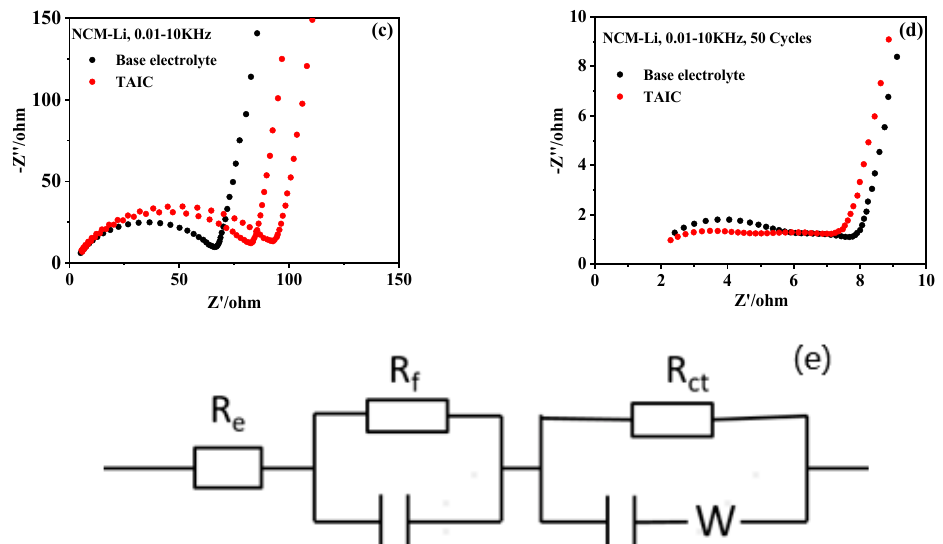
Figure 3. ( a ) The cycle curve of NCM-Li half-cell (The solid balls represent the cyclic capacity attenuation, and the hollow balls represent the charging-discharging efficiency in the cyclic process); ( b ) The charge–discharge curve during the charging process; ( c ) Representative EIS Nyquist plots of NCM-Li half-cells prepared with different electrolyte models measured after the first discharge–charge cycle at 0.1 C; ( d ) Representative EIS Nyquist plots of NCM-Li half-cell with different electrolyte models after the 50th discharge–charge cycle; ( e ) An equivalent circuit model.